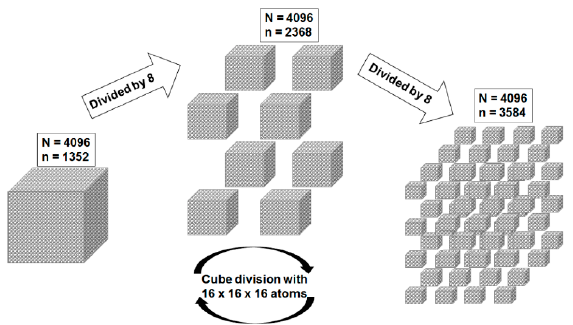
Figure 7. Surface statistic consequence of dividing a cube, where N is the total number of atoms and n is the number of surface atoms (Redraw and adapted figure from [73]). The cube contains a number of 4096 atoms, from which 1352 are located on the surface, therefore ~33% of the atoms are surface atoms. In the case that the cube is divided into eight equal 8 × 8 × 8 cubes, the overall number is the same, but 2368 atoms are located at the surface, which means ~58% of the atoms are located on the surface. If the same operation is repeated, 3584 atoms are obtained at the surface, which means ~88% surface atoms.